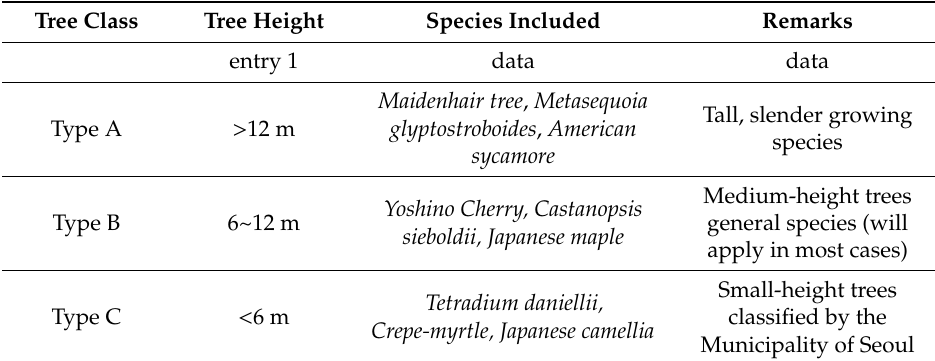
Table 2. Seoul tree classification depending on tree